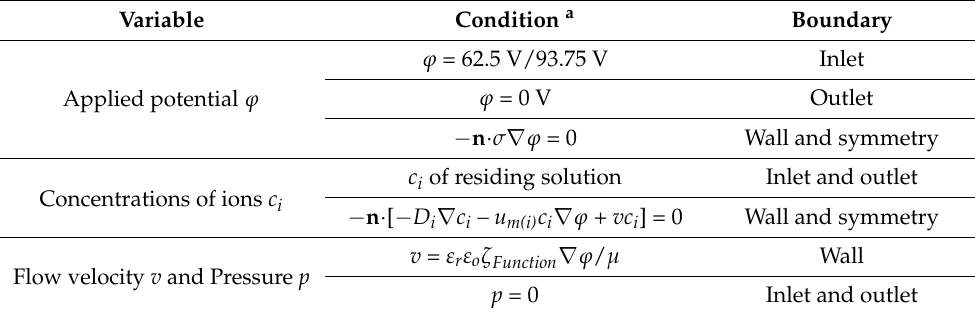
Table 5. Boundary conditions for the steady-state single fluid EOF numerical